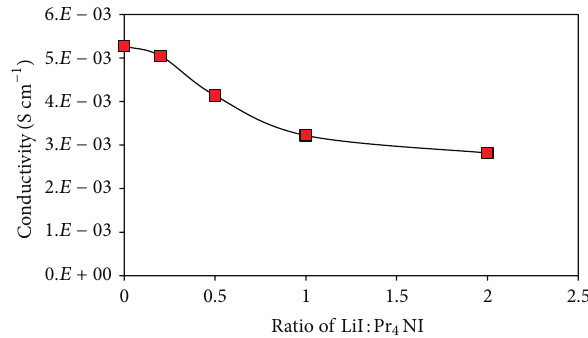
Figure 6: Effect of various LiI: Pr 4 NI compositions on the conduc- tivity.